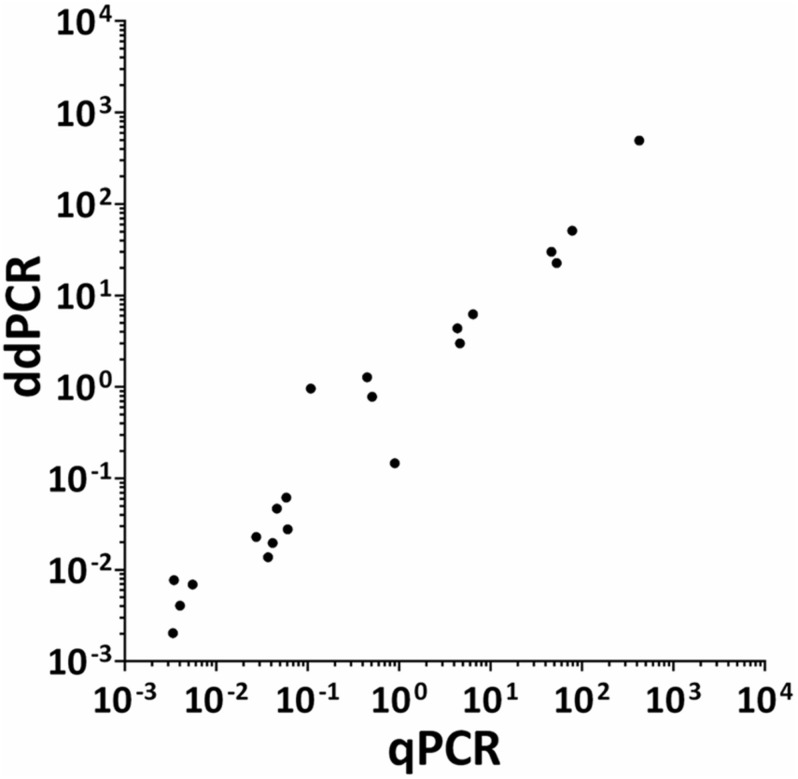
Correlation between ddPCR and qPCR results for HPV viral DNA load in CIN specimens and cervical cancer cell lines. Quantitative results obtained by both ddPCR and qPCR in HPV-positive samples (n = 21), including CIN specimens (n = 18) and SiHa, CaSKi, and HeLa cervical cancer cell lines, were compared between the two respective assays. Quantitative results are reported as Log 10 of HPV DNA copy/cell. Results from ddPCR and qPCR significantly correlated with a R2 = 0.9706 and P = 0.0001. Linear regression analysis was performed using GraphPad Prism software.